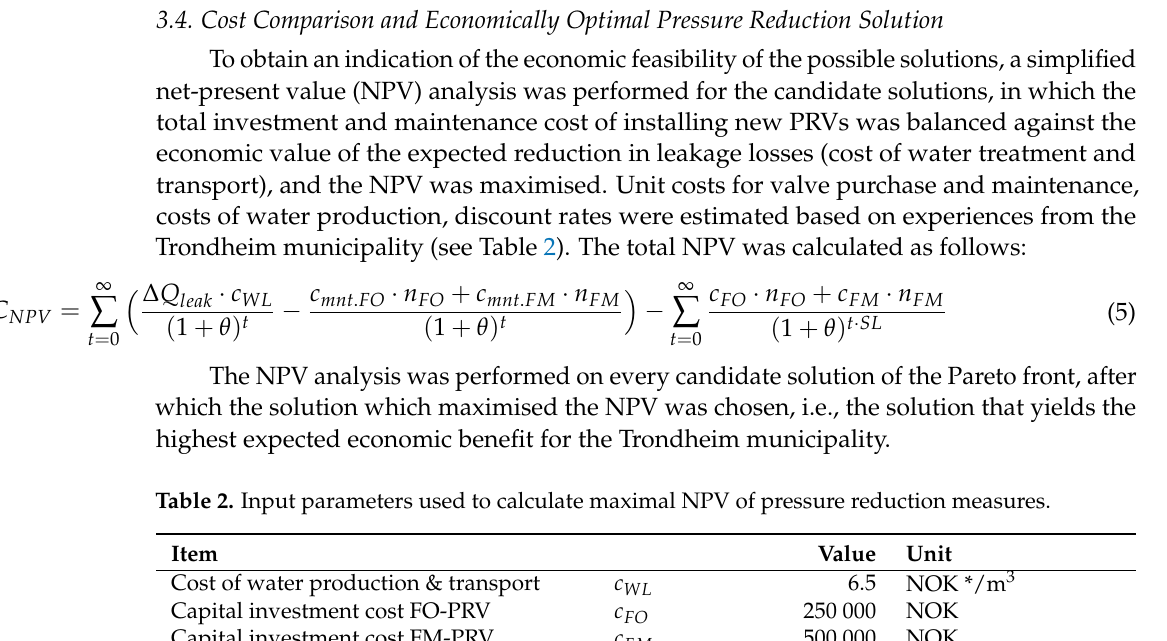
Figure 6. Resulting Pareto plot for the complete Trondheim WDN.